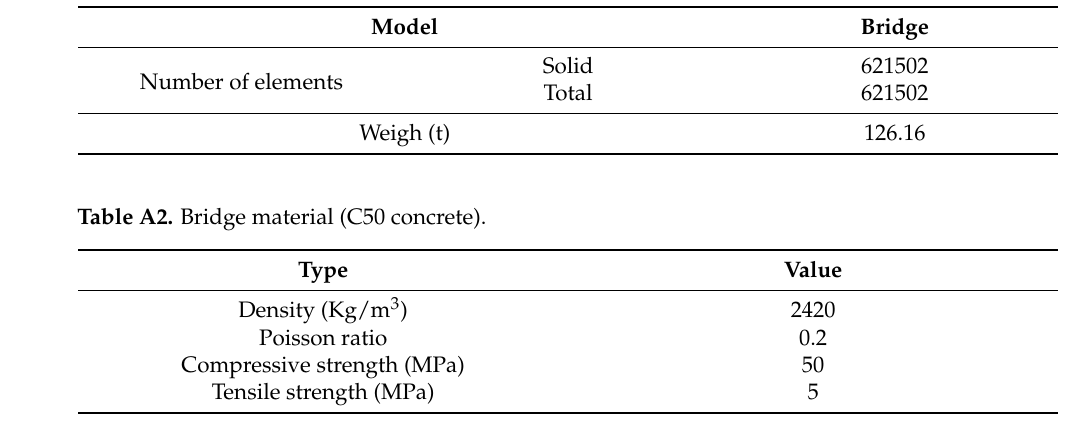
Table A1. Data of the bridge mode.